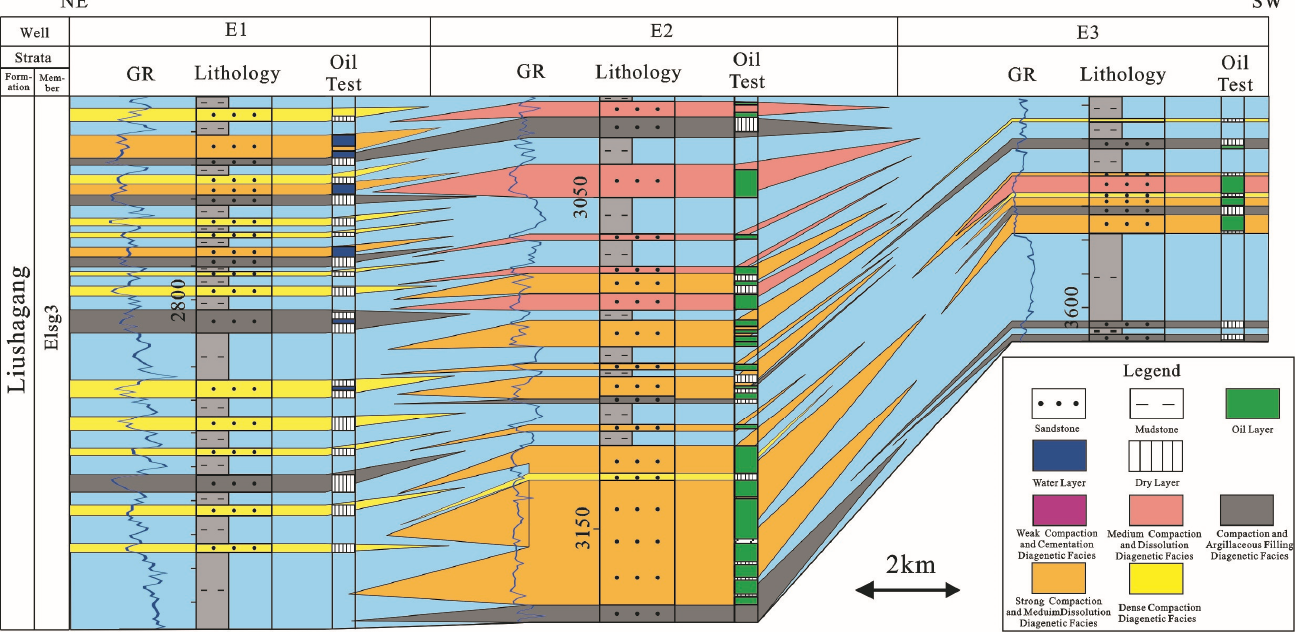
Figure 9. The diagenetic facies correlation section from wells E1 to E3 showing the diagenetic evolution of the east area in the Weixinan Sag (the section location is shown in Figure 1).